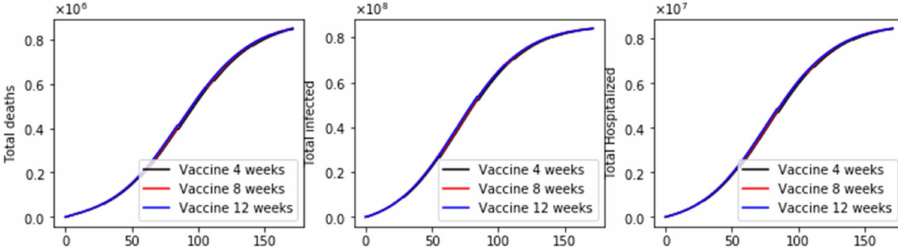
Figure 7. Dynamics of the total number of deaths, hospitalized, and infected, under the different time interval vaccine regimens. This scenario considers a transmission rate such that the basic reproduction number R 0 is greater than one, the vaccination pace is just 100,000 per day, and the vaccine efficacy after the first dose is 60% and 95% after the second dose.